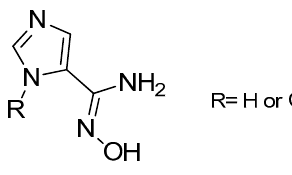
Figure 12. Imidazole amidoximes able to increase cGMP formation.